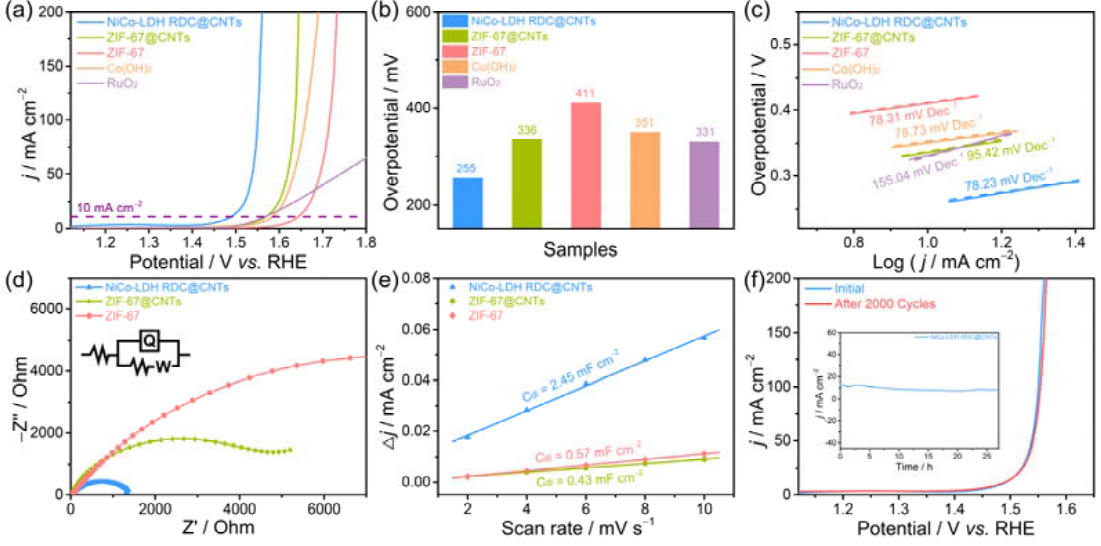
Figure 5. Electrocatalytic performance of different samples toward OER: ( a ) the OER polarization curves, ( b ) overpotentials at a current density of 10 mA cm − 2 , ( c ) Tafel plots, ( d ) fitted EIS Nyquist plots, and the inset shows the equivalent circuit diagram, ( e ) C dl values of different samples, ( f ) the OER polarization curves of NiCo ‐ LDH RDC@CNTs before and after 2000 cycles, inset shows the chronopotentiometry curve of NiCo ‐ LDH RDC@CNTs.